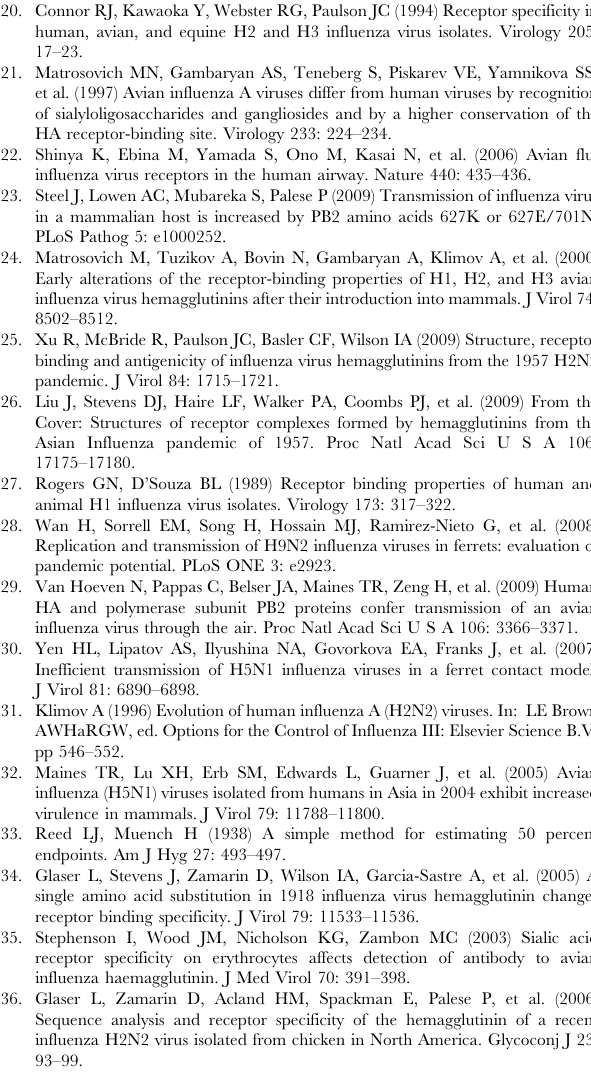
Table S2 Glycans used on arrays for detecting long and short a 2-3/ a 2-6 sialylated chains. Key: Neu5Ac: N-acetyl D-neur- aminic acid; Gal: D-galatose; GlcNAc: N-acetyl D-glucosamine. a / b : anomeric configuration of the pyranose sugars. All the sugars are linked via a spacer to biotin (-Sp-LC-LC-Biotin as described in http://www.functionalglycomics.org/static/ consortium/resources/resourcecored5.shtml). Found at: doi:10.1371/journal.pone.0011158.s003 (0.07